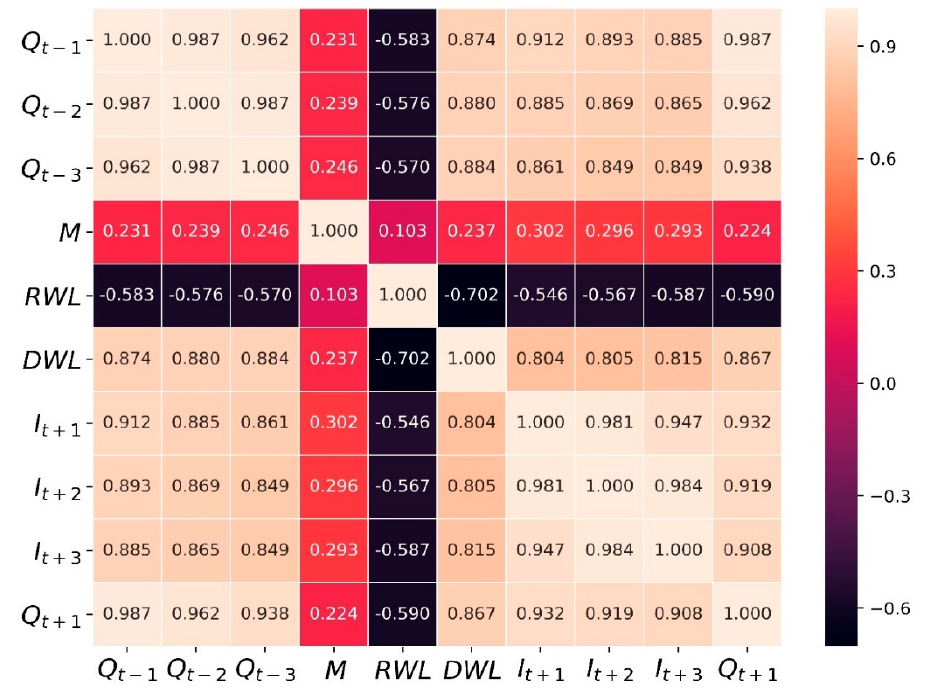
Figure 8. Correlation matrix between all input variables and outflow.